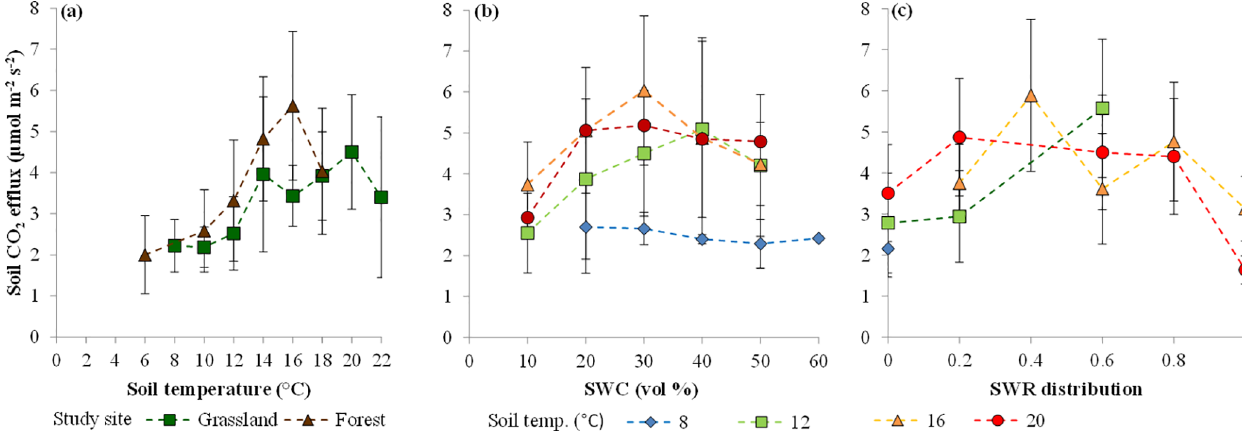
Figure 5. Relationship between soil CO 2 efflux and (a) soil temperature, (b) soil water content (SWC) and (c) soil water repellency (SWR) distribution. In (a) results are separated for the forest and grassland sites and soil CO 2 effluxes are represented as means with SD for soil temperature grouped into 2 ◦ C classes ( ± 1 ◦ C). In (b) and (c) results from the forest site and the grassland sites are combined and separated into 4 soil temperature classes. Soil CO 2 effluxes are represented as means with SDs. In (b) the results were grouped into SWC classes of 10 vol.% and in (c) were grouped into SWR distribution classes ( ± 0.1) representing a relative fraction of extremely water-repellent soil. The SWR axis minimum 0 represents wettable soil, while the maximum of 1 denotes uniformly extreme SWR. Only results from the vegetated sites have been used to create the figures ( n =